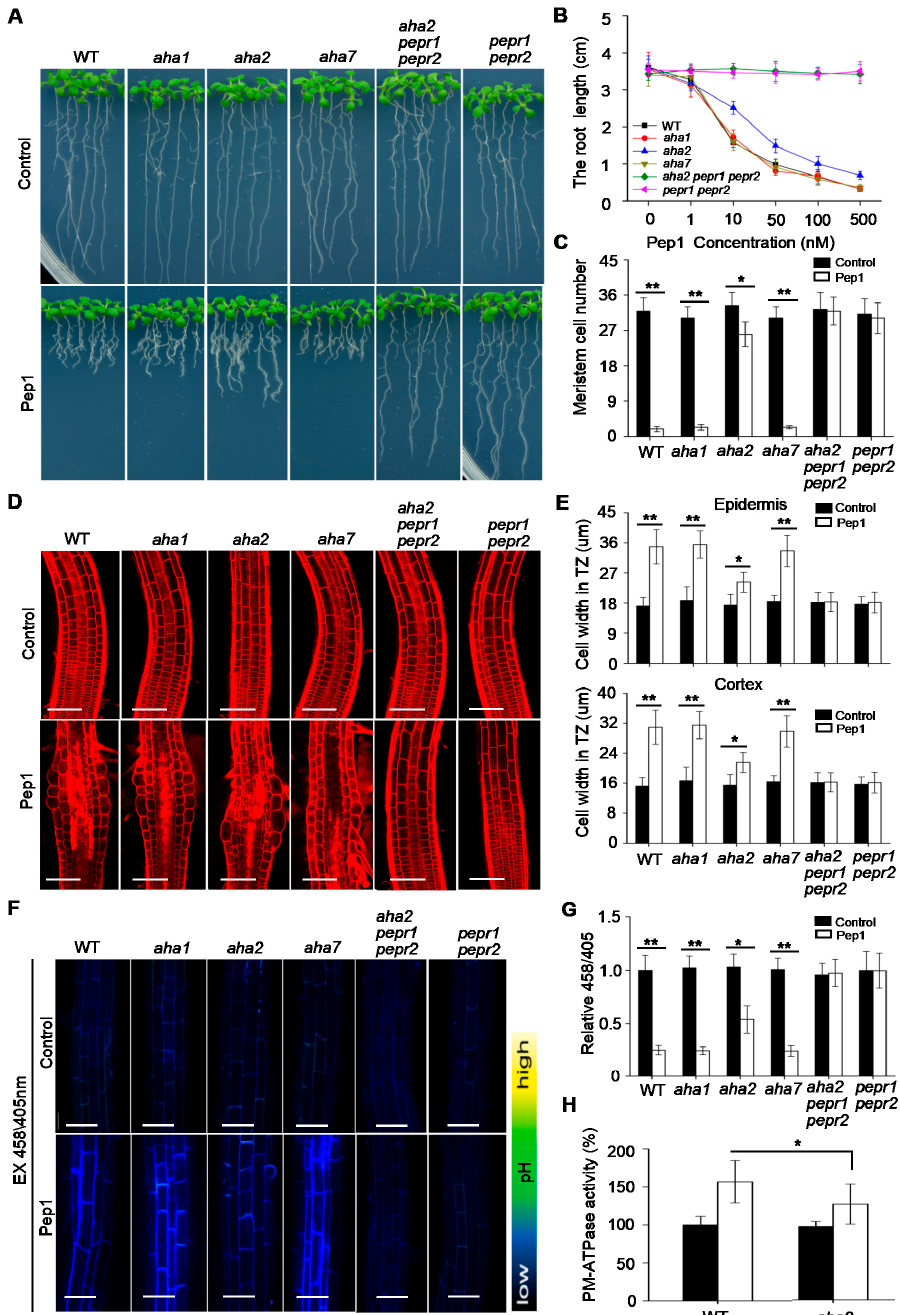
Figure 4. AHA2 is required to regulate the Pep1 signaling in roots. ( A ) The growth phenotype of wild-type (WT), aha1 , aha2 , aha7 , aha2 pepr1 pepr2, and pepr1 pepr2 root. Three-day-old seedings were transferred on half-strength MS agar medium supplemented with or without (Control) 100 nM Pep1